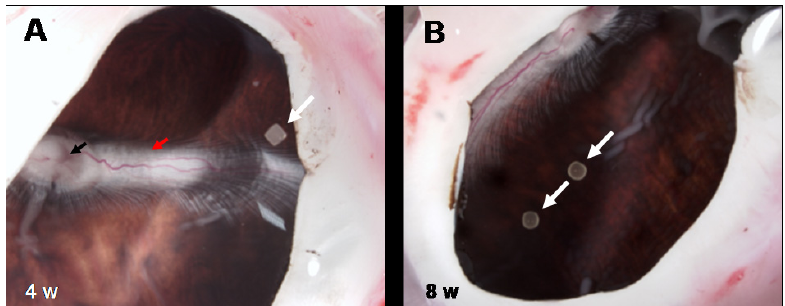
Figure 12. Macroscopic examination of enucleated eyes with intravitreal implants of PEA fibrils. Examination of enucleated eyes with intravitreal PEA fibril implants (white arrows) ( A ) four and ( B ) eight weeks after implantation shows an attached retina with papilla (black arrow) and nerve (red arrow) perfused and myelinated.